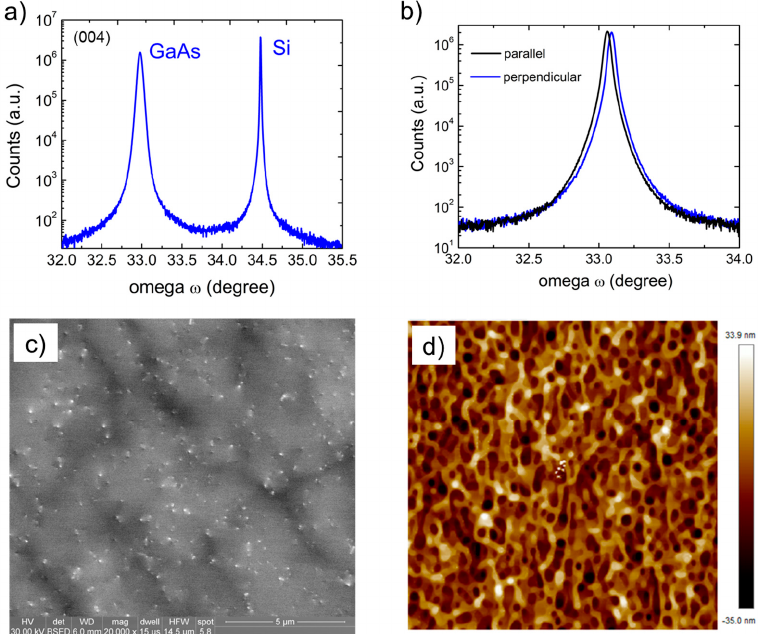
Figure 3. ( a ) ω -2 θ scan, ( b ) w rocking curve, ( c ) ECCI, and ( d ) AFM scan of GaAs on Si epitaxial